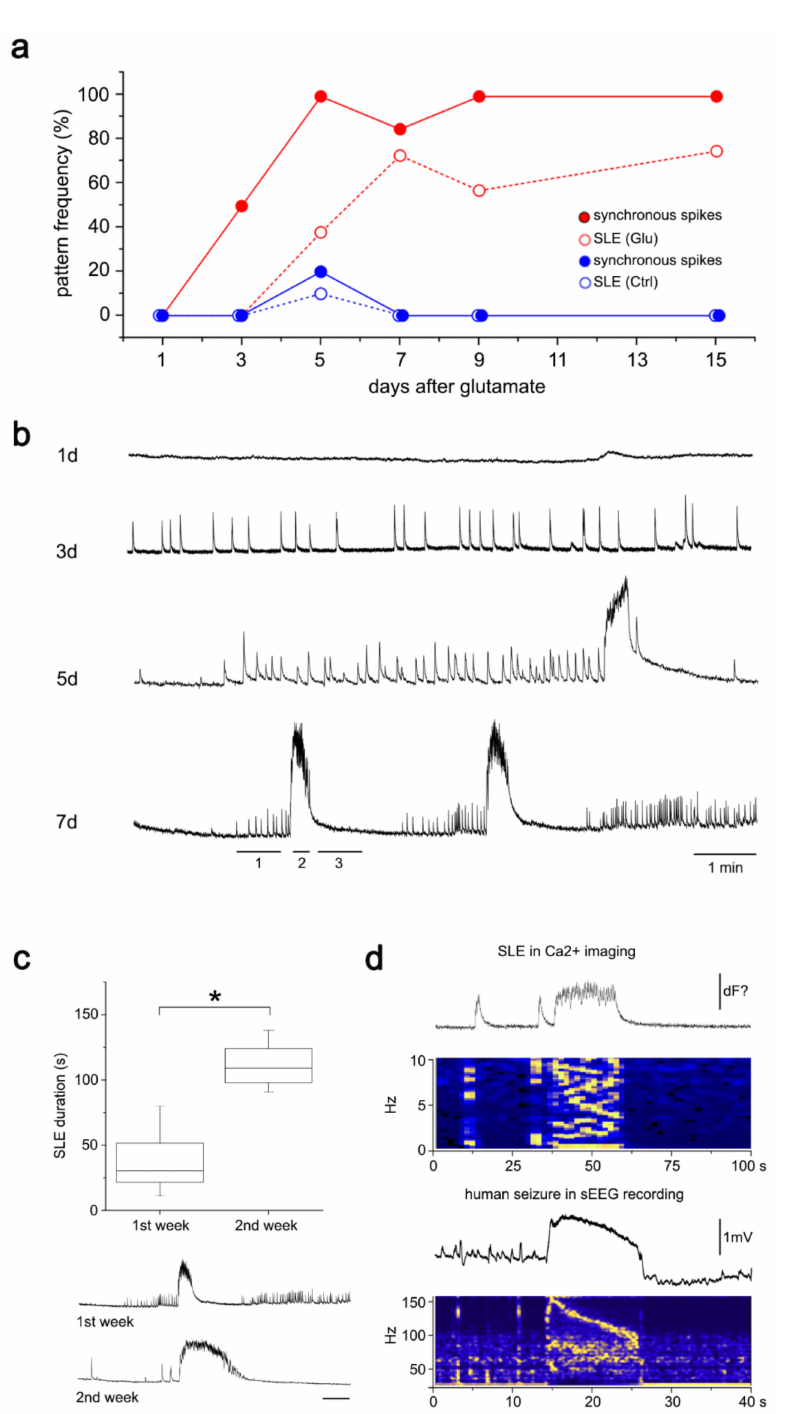
Figure 1. Calcium (Ca 2+ ) imaging identified seizure-like activity in vitro. Glutamate-treated rat pri- mary neuronal cultures showed temporal epileptogenic network activity starting after a short latency period with synchronized spiking and later development of seizure-like events (SLE; ( a , b )), which progressed and became longer, showing a duration up to two minutes ( c ). SLEs were characterized by a sharp-onset/sharp-offset transient superimposed on low-voltage fast activity, high-amplitude rhyth- mic bursts, and postictal depression, thereby showing strong similarities with human stereo-EEG (sEEG) seizure. Traces from individual cells and sEEG contacts are displayed for comparison. Relative power spectrograms summarizing network activity in vitro and in vivo show typical down-chirping (i.e., linear decrease in frequency) ( d ). Ctrl—control (blue), Glu—glutamate (red), sEEG—intracranial stereo-electroencephalogram recording, SLE—seizure-like event. Asterisk (*) indicates